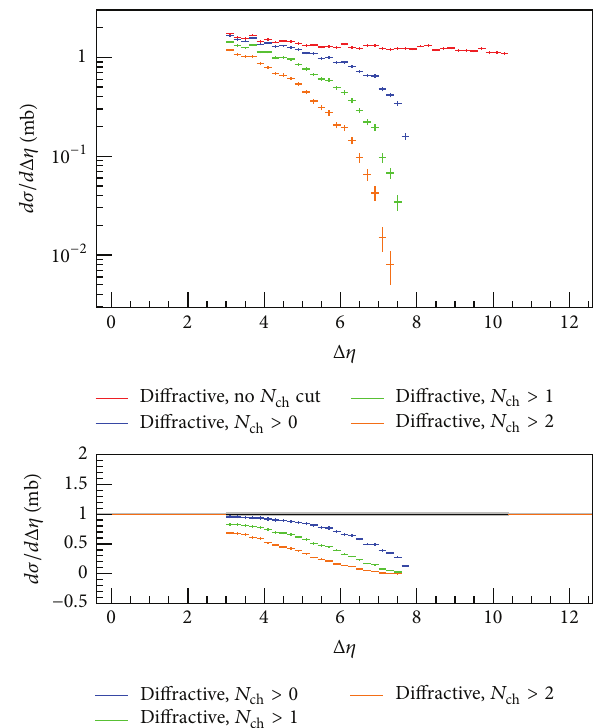
Figure 13: Diffractive dissociation events without a primary vertex and with a primary vertex for the different number of charged particles, |𝜂| < 2.5 , and 𝑝 > 200 MeV charged particles are used to form the vertex. Only the events that have an 𝑁 ch . Tracker region is considered as T edge gap Δ𝜂 > 3 with a cut of 𝑝 T > 200 MeV for all final state particles in |𝜂| < 5.2 are considered. The vertex requirement suppresses the events that have Δ𝜂 > 8 which corresponds to the very low-mass soft diffractive processes.